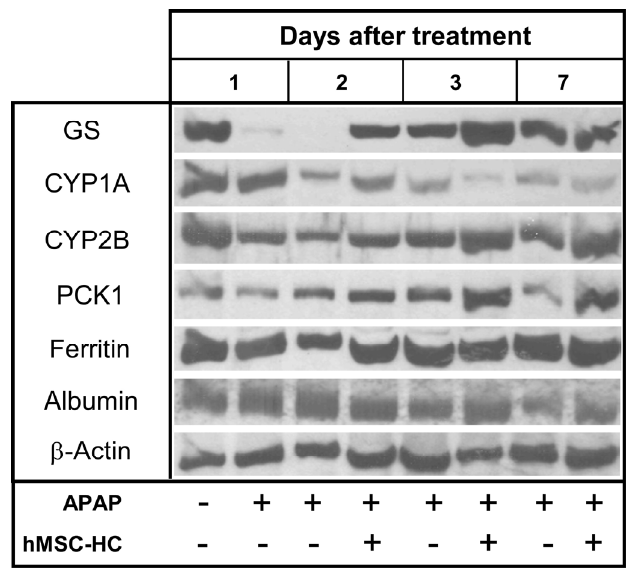
Figure 8. Time course of the expression of functional marker proteins after APAP treatment. Mice were injected APAP as indicated. One day later (=1 day after treatment), one third hepatectomy was conducted and hMSC-HC were delivered via intrasplenic injection (+hMSC-HC) as described in Materials and Methods. Controls received PBS instead of hMSC-HC ( − hMSC-MSC). Another 1 day (=2 days after treatment), 2 days (=3 days after treatment) and 6 days (=7 days after treatment) later, livers were harvested and cytosolic extracts were prepared for Western blot analyses. The expression of the perivenous marker enzymes glutamine synthetase (GS) and cytochromes P450 1A and 2B, the periportal marker enzyme phosphoenolpyruvate carboxykinase (PCK1) and the plasma proteins ferritin and albumin were detected using the specific antibodies as listed in Table 3. β -actin served as a loading control. The blots shown represent a series of 2–3 different